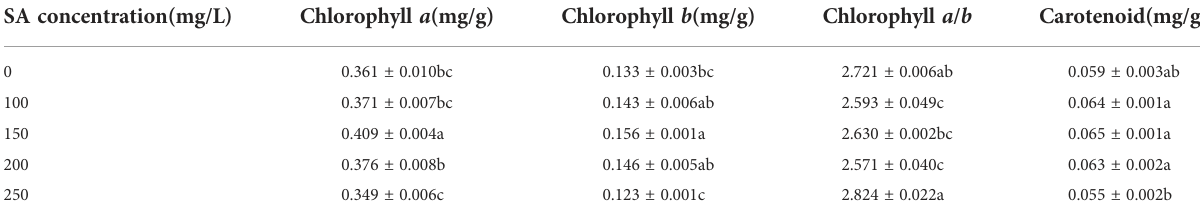
TABLE 1 Photosynthetic pigment content in Nasturtium of fi cinale